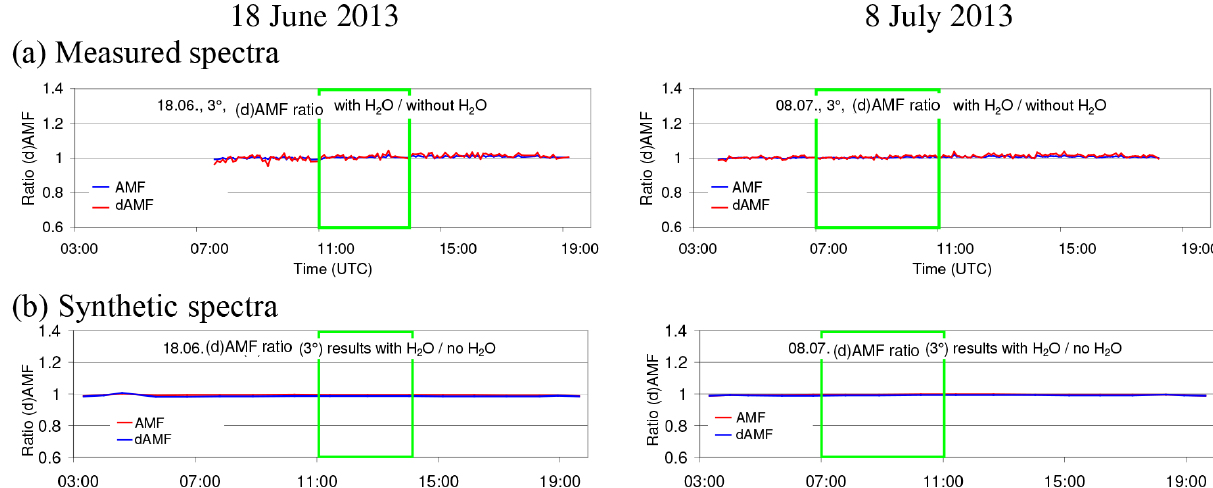
Figure A22. Ratios of the O 4 (d)AMFs derived for the analysis including a H 2 O cross section vs. those for the standard analysis (no H 2 O cross section) for both selected days ( a : results for spectra measured by the MPIC instrument; b : results for synthetic spectra when taking into account the temperature dependence of the O 4 cross section).